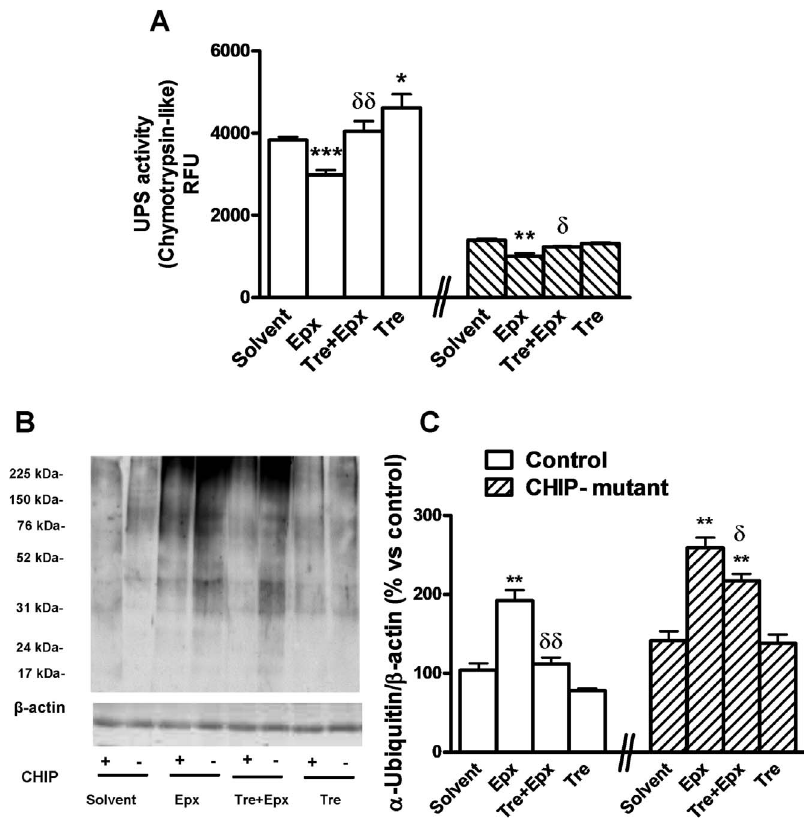
Figure 4. UPS activity in control and CHIP-mutant fibroblasts. Trehalose protects from ubiquitin protein accumulation by epoxomicin in CHIP-mutant and control human fibroblasts. A ) Differential UPS activity in control and CHIP mutant fibroblasts. B ) Accumulation of poly- ubiquitinated proteins and C ) their corresponding densitometry analysis after 24 h of treatment corresponds to the whole smear. Data of the control and CHIP-mutant groups were analyzed independently, no inter-group statistical analysis was performed. Data are expressed as the mean 6 SEM. Every value in 4A corresponds to the mean of two experiments: the mean of 4 independent dishes of cells of 3 different controls (n=3) and for the CHIP-mutant group six independent dishes of one only patient (pseudo-replicates, n=6). In 4C values are the mean of two independent experiments, with 6 cell dishes (pseudo-replicates, n=6) of the patient group and, in the control group, the mean of 3 different dishes of cells for each one of the 3 controls (n=3). Statistical analysis was performed by Student’s t-test. *p , 0.05, **p , 0.01, ***p , 0.001 vs solvents; d p , 0.05, dd p , 0.01 trehalose + epoxomicin vs epoxomicin treated cultures.